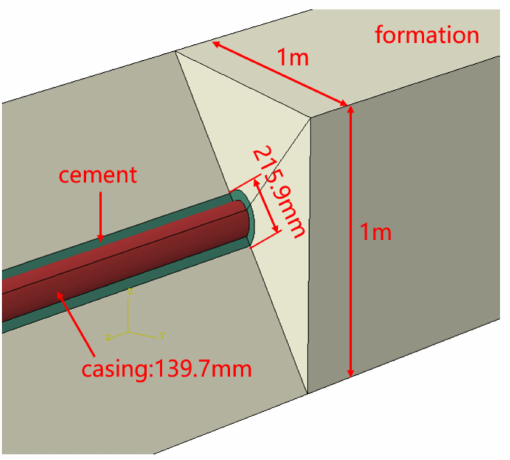
Figure 8. Schematic diagram of finite element model (formation–cement–casing).